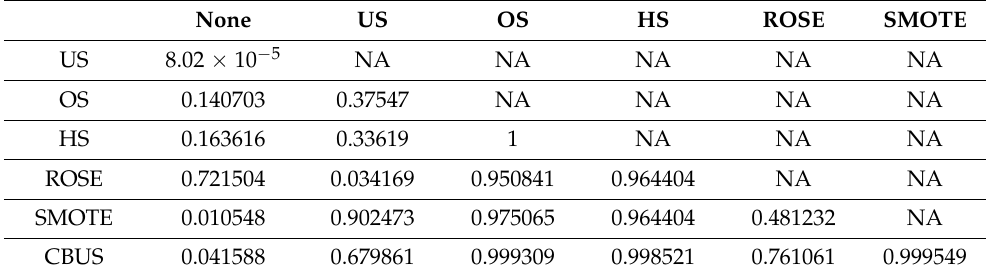
Table 11. Post hoc analysis using Nemenyi multiple comparison test for NB